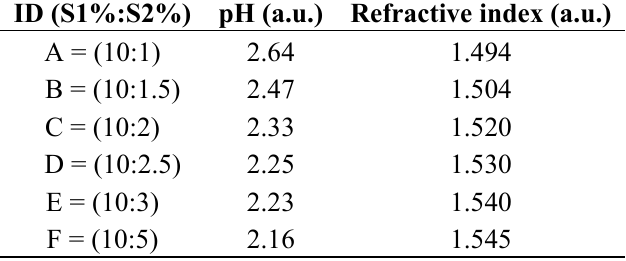
Table 2. Solution S1 and S2, are the base solutions. The second and third columns show pH and refraction index of different PVA + FeCl 3